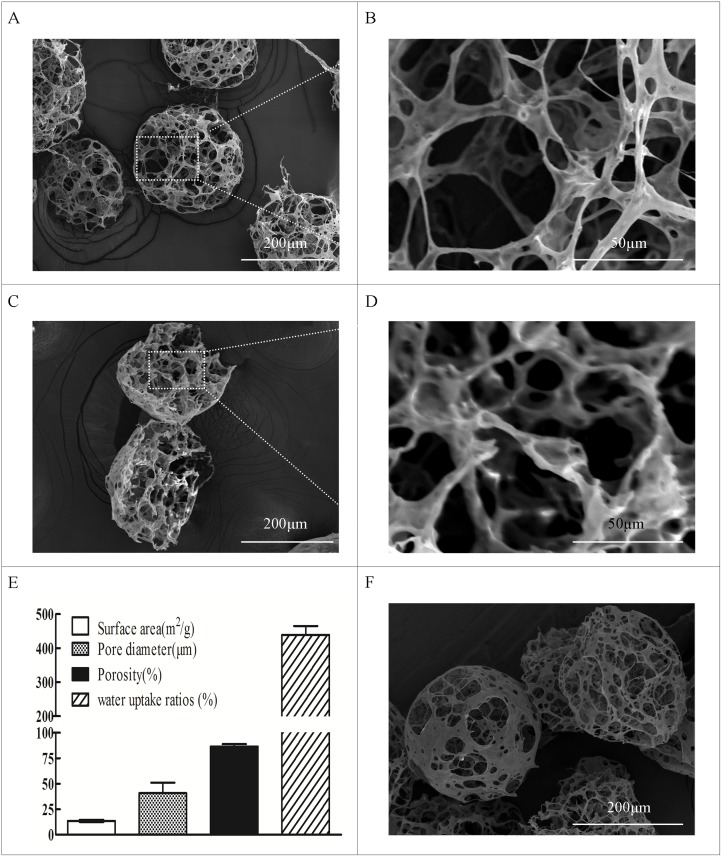
Physical characteristics of PBLG microspheres.(A, B) SEM examination of the whole porous PBLG microcarriers. (C, D) Cross-sectional view of porous PBLG microcarriers. (E) Porosity and pore diameters of PBLG microcarriers (n = 3). (F) SEM examination of injected porous PBLG microcarriers.